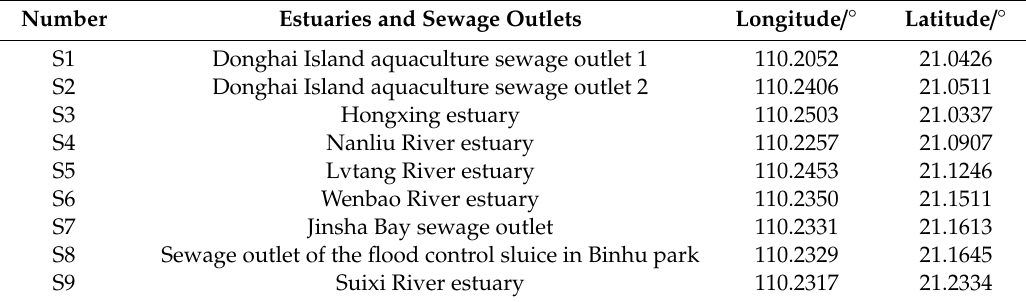
Table 1. Investigation of estuaries and sewage outlets in ZJB